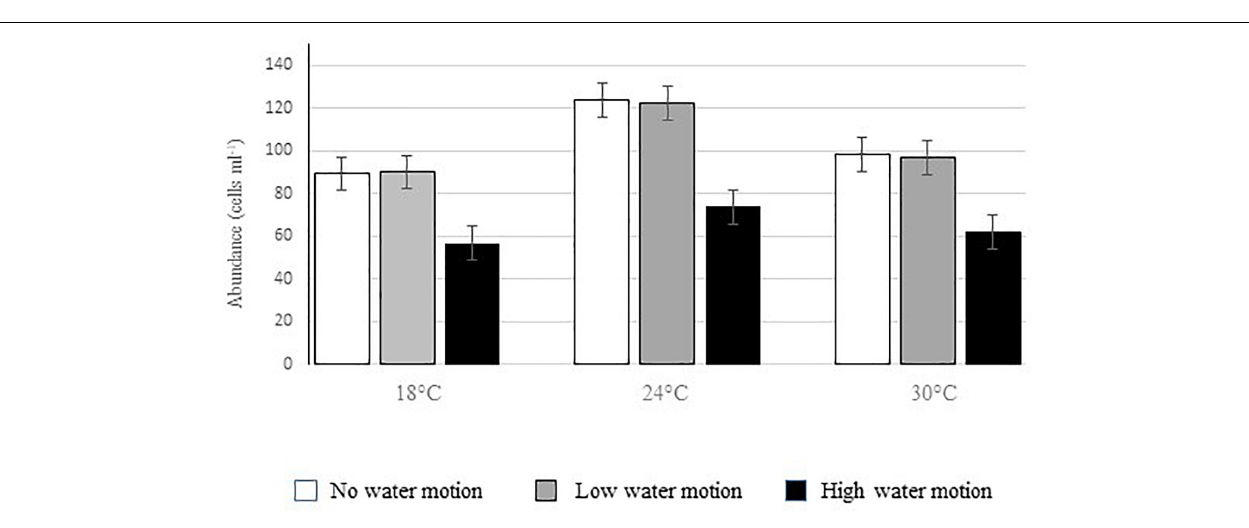
FIGURE 9 | Mean ( ± ES) abundance of the observed gametes in the aquaria with different temperature and water motion